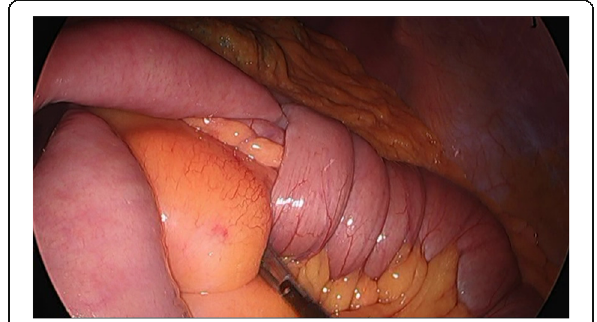
Fig. 3 Intraoperative laparoscopic finding showed intussusception of the